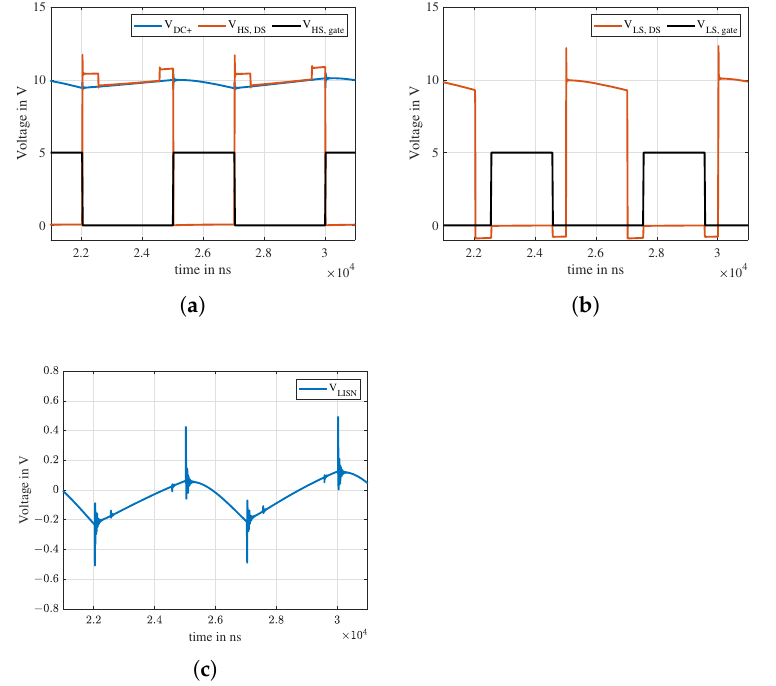
Figure 24. Simulated time domain signals of the assembly shown in Figure 15 with a supply voltage of 10 V. ( a ) High side transistor gate voltage V HS , gate , drain-source voltage V HS , DS , and the positive supply line voltage V DC + . ( b ) Low side transistor gate voltage V LS , gate and drain-source voltage V LS , DS . ( c ) LISN P output